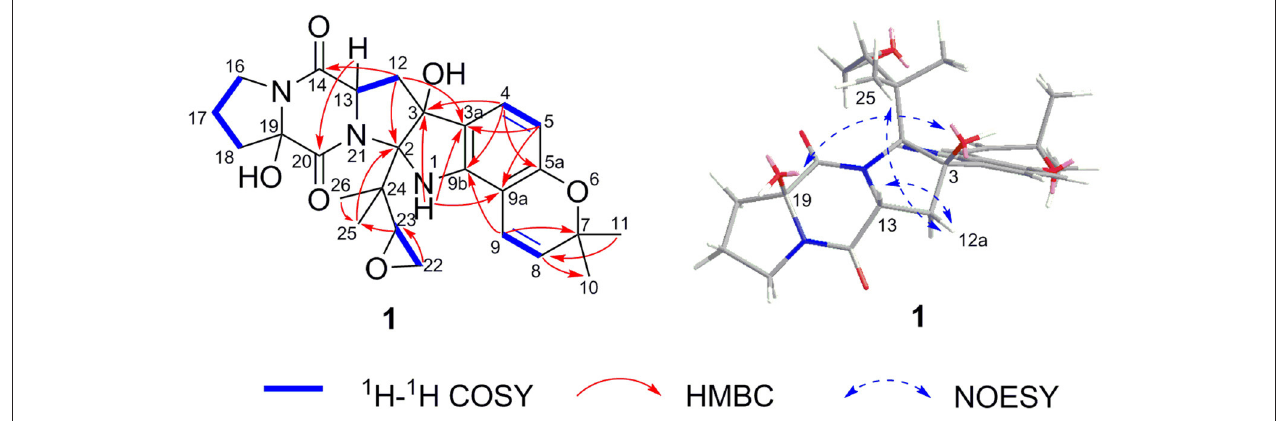
FIGURE 3 | Key 2D NMR correlations for 1 .